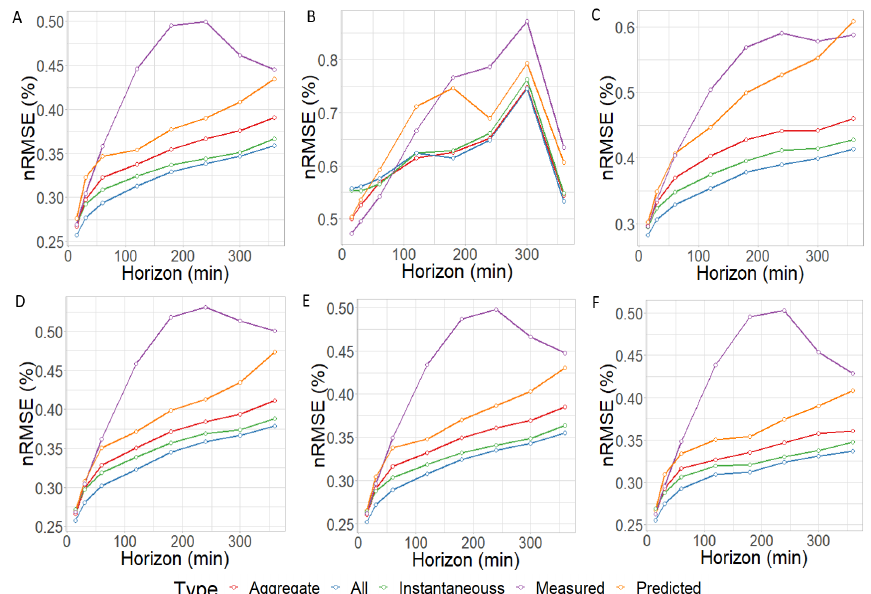
Figure 1. NRMSE for all modules considering different inputs to the ML algorithm. Top row : NRMSE of panels A, B and C. Bottom row : NRMSE of panels D, E and F.